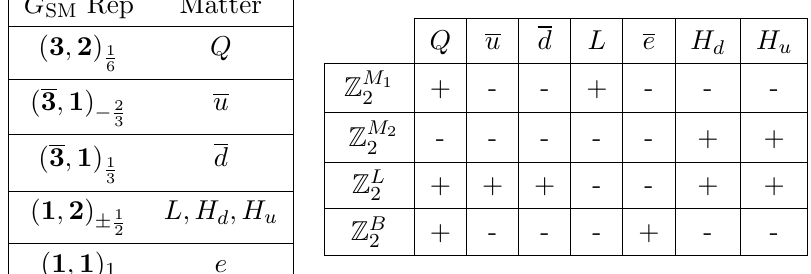
Table 1 . Summary of gauge quantum numbers of chiral MSSM super(cid:12)elds. The left table shows the gauged quantum numbers, while the table on the right shows the Z 2 charge assignments for